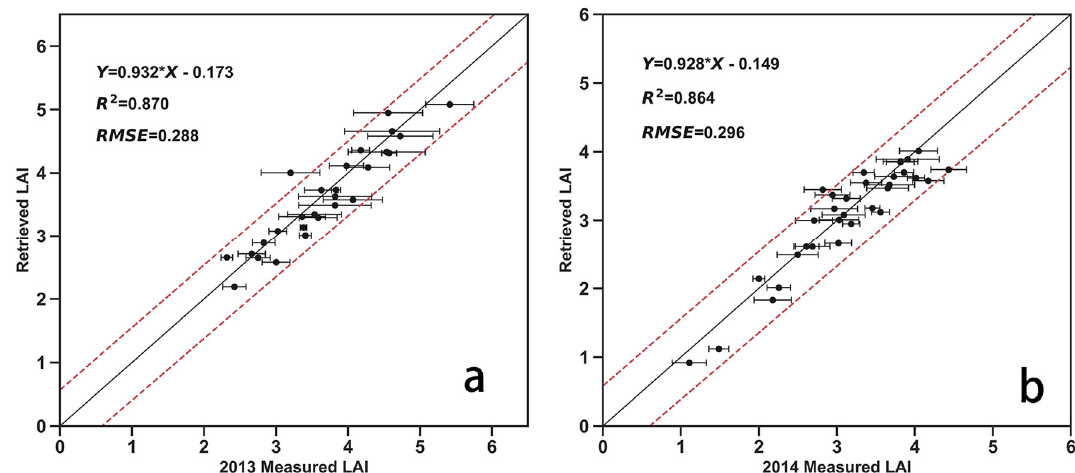
Figure 8. Comparison between the HR LAI retrievals and ground measurements, which in 2013 were derived from ( a ) LAINet and in 2014 were derived from ( b ) LAI-2000. The error bars represent the standard deviation of the ground measurements from LAI instrument. The black solid line is the 1:1 reference line, while the red dotted lines show the 95% confidence interval around the NARX model’s